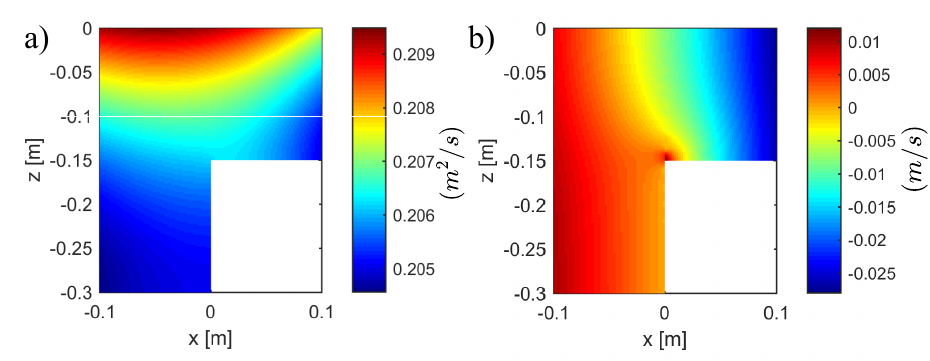
Figure 2. ( a ) Velocity potential at the first-order φ 1 near the step. ( b ) Horizontal velocity at the first-order ∂ x φ 1 near the